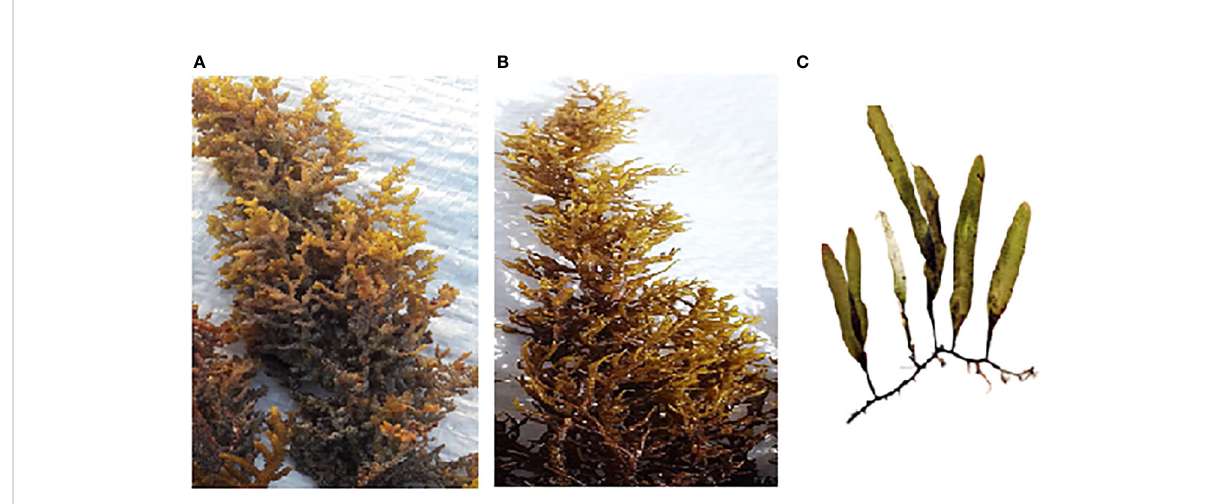
FIGURE 2 Macroalgal species used for the biosynthesis of Au-NPs (A) Cystoseira myrica , (B) Cystoseira trinodis , and (C) Caulerpa prolifera .